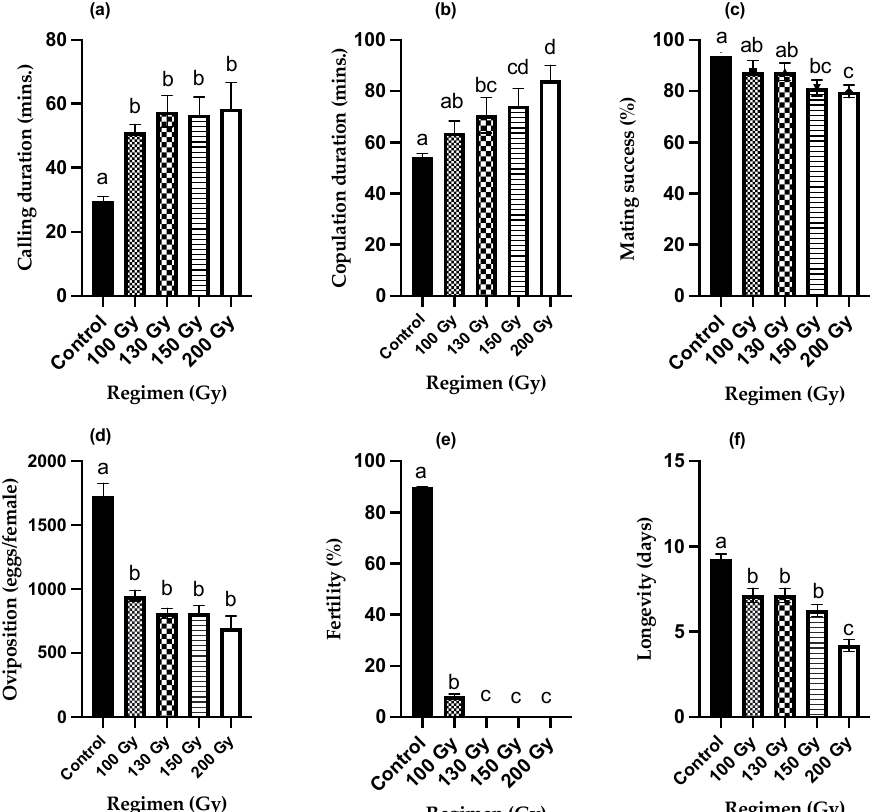
Figure 1. Effect of ionizing radiation on reproductive behavior of female Spodoptera litura . ( a ) Calling duration (min), ( b ) copulation duration (min), ( c ) mating success (%), ( d ) oviposition (eggs/female), ( e ) fertility (%), ( f ) longevity (days). n = 15, percentage (%) data was arcsine transformed before ANOVA, whereas the data representing the bars are back transformations. Means ± SE followed by same letters are not statistically different at p < 0.05 (one-way ANOVA followed by Tukey’s multiple comparison test).